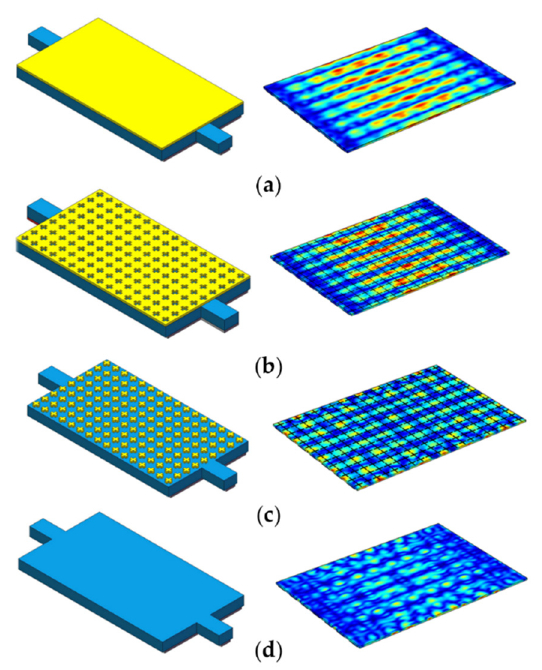
Figure 3. The structure diagrams and simulated displacement-field distributions of different AlN LMRs with ( a ) floating electrodes, ( b ) a subwavelength aperture array, ( c ) a particle array, ( d ) open electrode on the surface of the AlN film.